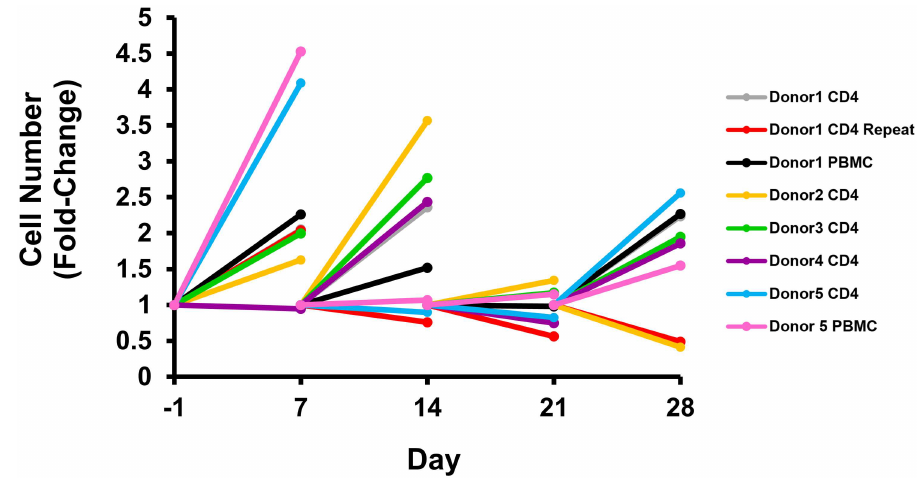
Fig 3. Cell number changes during cell culture. Cell numbersat the conclusionof each week are normalized relative to the total number of cells that were seeded in the flask at the beginningof each week.